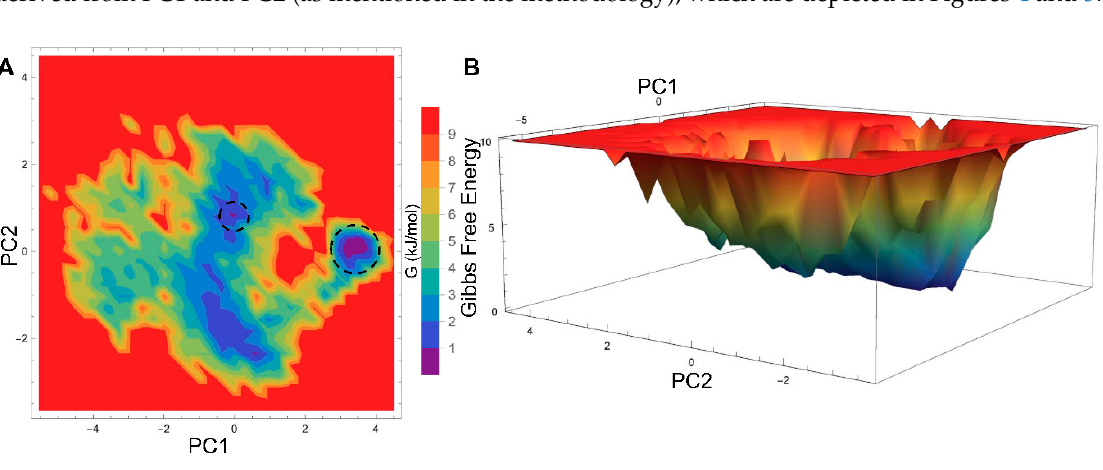
Figure 3. Projection of the different structural conformations onto PC1 and PC2 for three PPAR- α systems. ( A ) Two-dimensional (2D) projection of the selected eigenvectors throughout 300 ns MD simulation. Data for apo, agonist-, and antagonist-bound forms of PPAR- α are represented in gray, salmon, and cyan colors, respectively. ( B ) The best principal components of eigenvalues that correspond to the first 20 eigenvectors are represented by the asterisk line point and their associated cumulative fluctuations are represented by the square line point. The global minimum energy conformation of the protein-ligand complex can be obtained through free energy landscape (FEL) analysis. The FEL contour maps for all three PPAR- α systems were derived from PC1 and PC2 (as mentioned in the methodology), which are depicted in Figures 4 and 5.